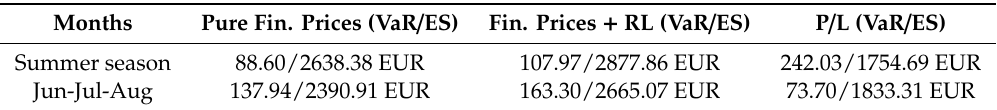
Table 8. Comparison between CDDs pure financial prices, financial prices + RL and P / L − summer season